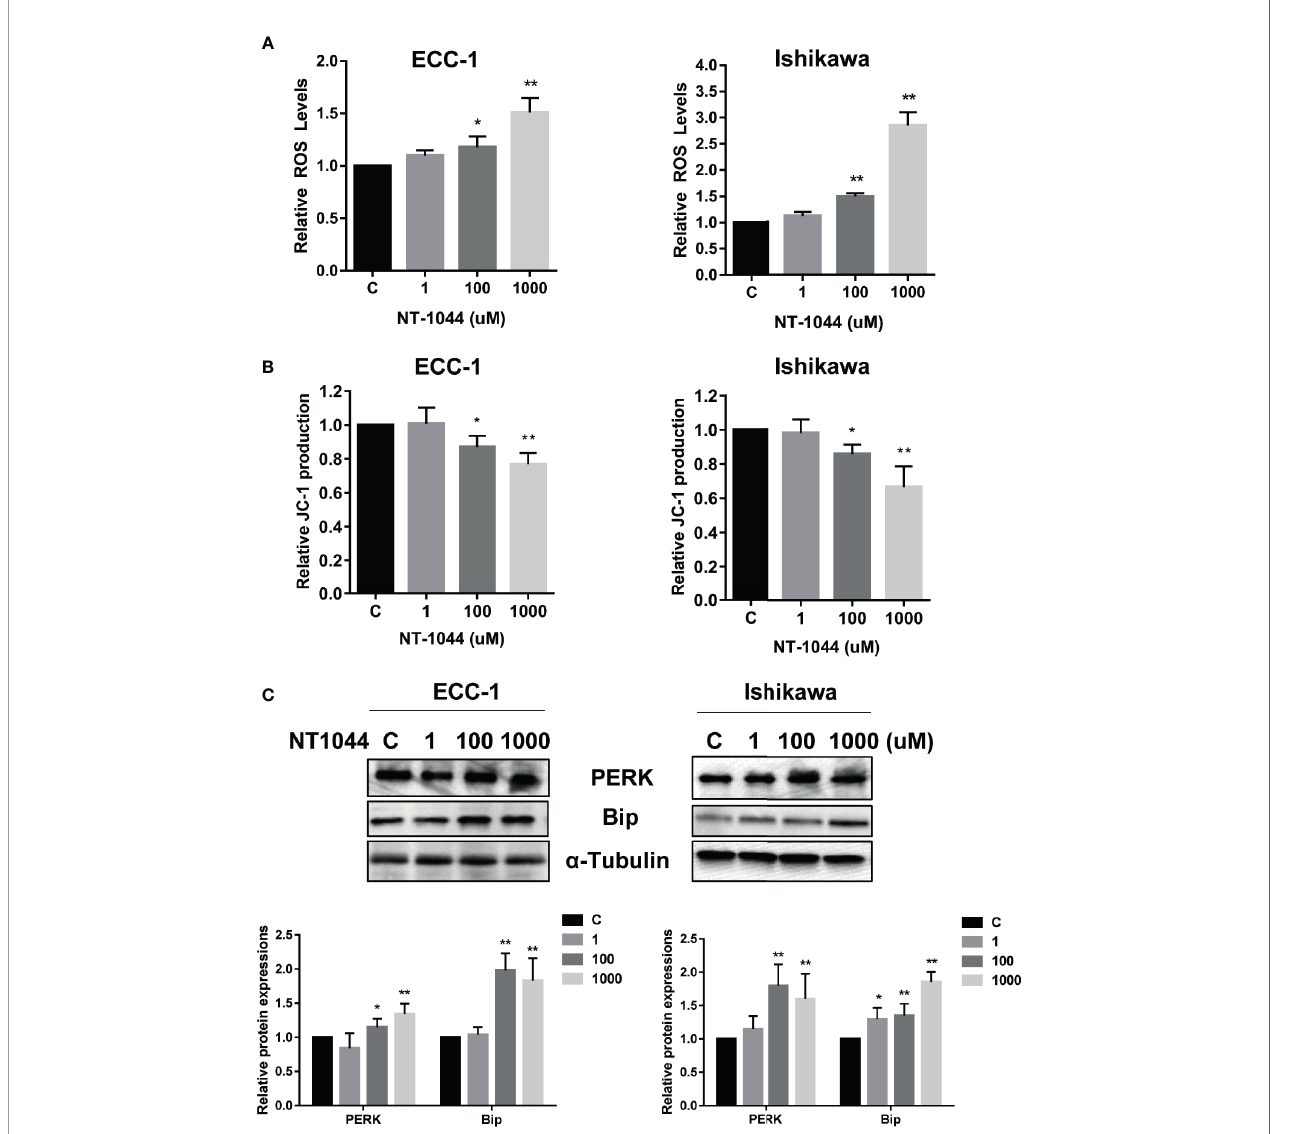
FIGURE 4 | NT-1044 induced cell stress in EC cells. The ECC-1 and Ishikawa cells were cultured for 24 hours and then treated with NT-1044 for 12 hours. Reactive Oxygen Species (ROS) was detected using the DCFH-DA Assay. Mitochondrial membrane potential was measured by JC-1 assay. NT-1044 signi fi cantly increased ROS products (A) and decreased JC-1 levels (B) in a dose dependent manner in the both cells. Both cells were treated with NT-1044 for 24 hours. Western blotting showed that NT-1044 increased the expression of BIP and PERK in the both cells (C) . *p < 0.05, **p <